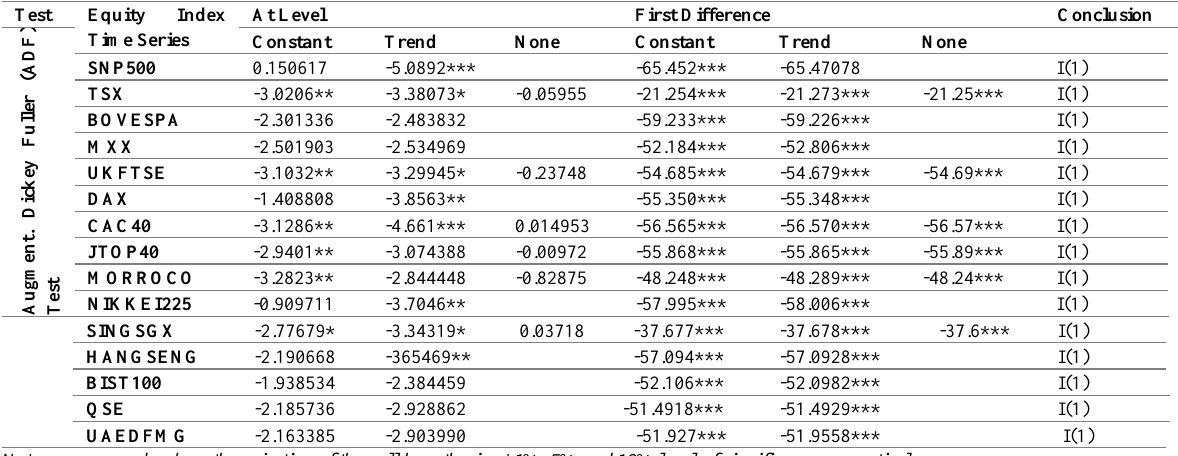
Table 4: Stationarity